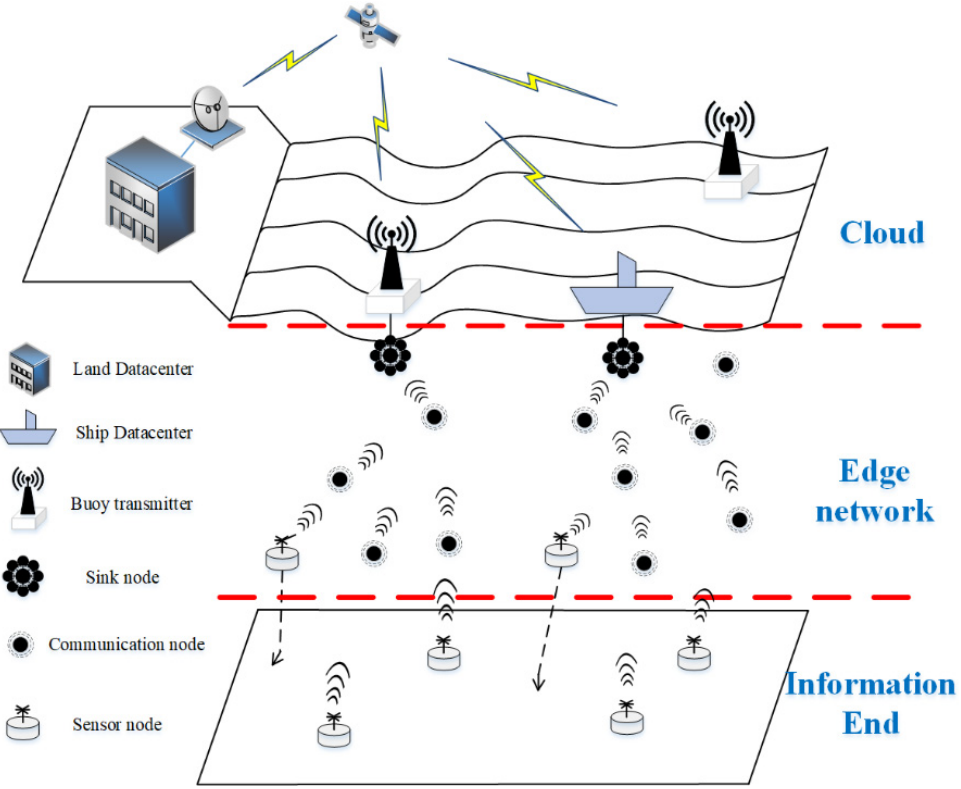
Figure 1. End–edge–cloud architecture of underwater wireless sensor networks.